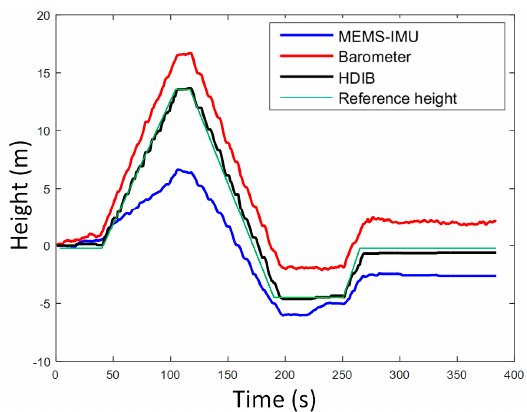
Figure 27. Height estimation results of MEMS-IMU, Barometer and HDIB of Height_4 trajectory. The blue line, red line and black line are height estimation from MEMS-IMU, barometer and HDIB, respectively. The green line is the reference height (true height).